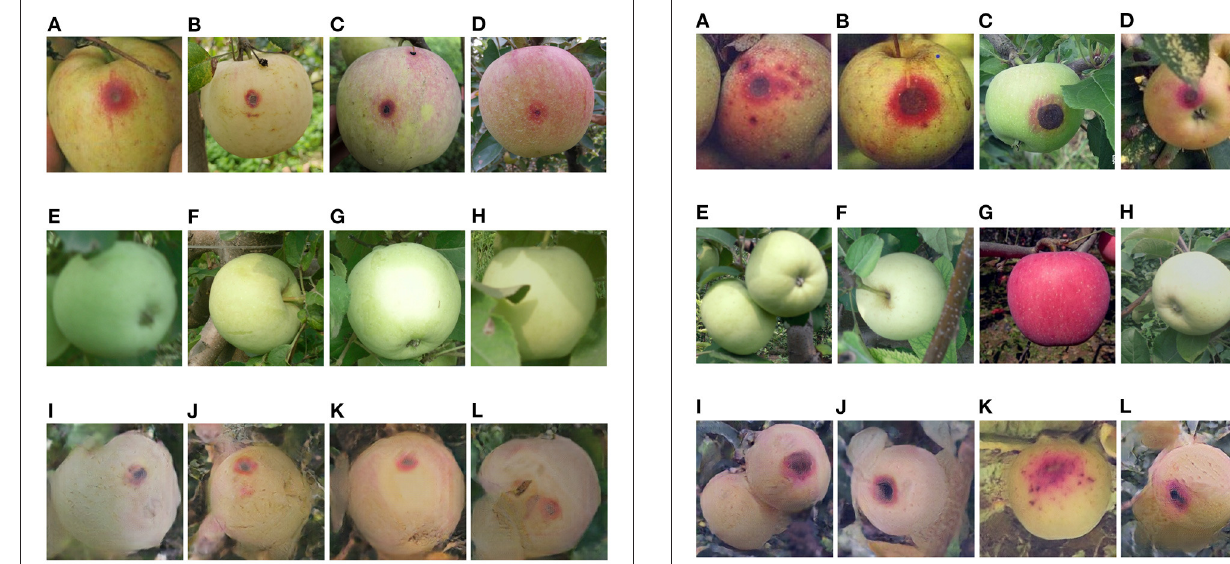
FIGURE 7 | (A–D) General anthracnose apple images captured in field, (E–H) healthy apple images, (I–L) general anthracnose apple images converted from the above healthy apple images by the Cycle-GAN method.